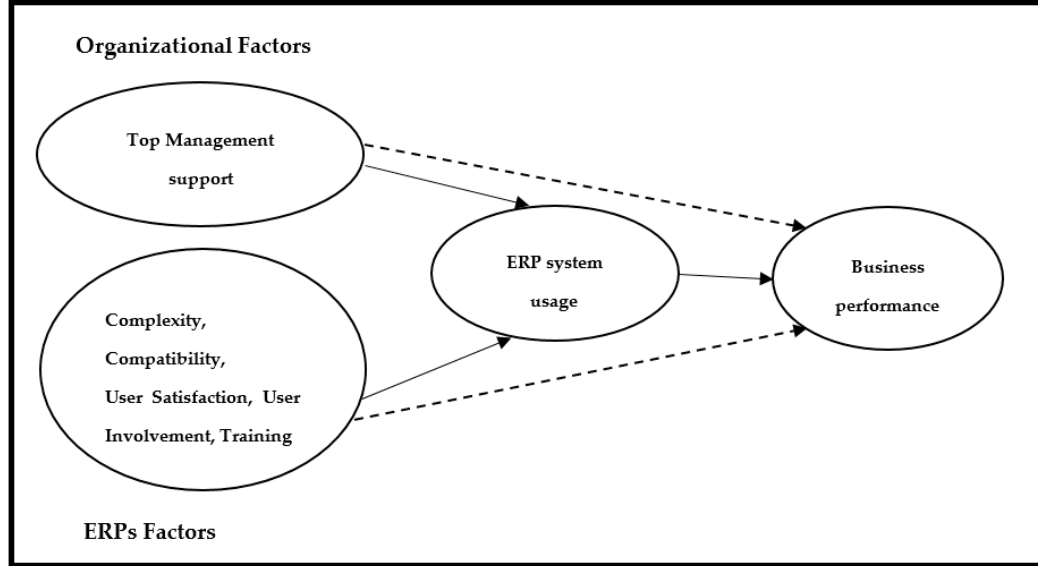
Figure 1. The proposed theoretical